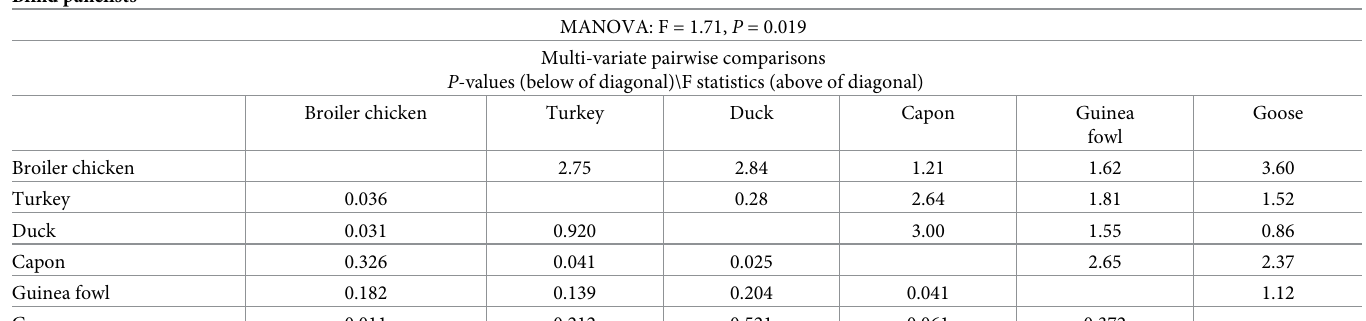
Table 2. Results of MANOVA (Wilks’s test) and multi-variate (based on all traits) pairwise comparisons based on F-test for traits of breast meat. Sighted panelists MANOVA: F = 10.14, P < 0.001 Multi-variate pairwise comparisons P -values (below of diagonal)\F statistics (above of diagonal) Broiler chicken Broiler chicken Turkey < 0.001 Duck Capon 0.051 < 0.001 Guinea fowl 0.008 Goose < 0.001 < 0.001 Blind panelists MANOVA: F = 1.71, P = 0.019 Multi-variate pairwise comparisons P -values (below of diagonal)\F statistics (above of diagonal)